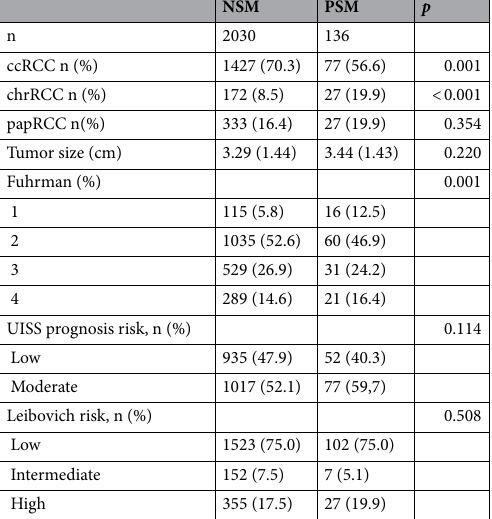
Table 3. Histological outcomes. NSM negative surgical margins, PSM positive surgical margins, ccRCC clearcell renal cell carcinoma, chRCC chromophobe renal cell carcinoma, papRCC papillary renal cell